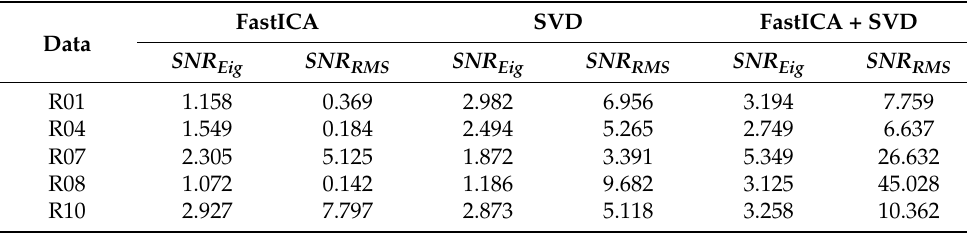
Table 1. Performance comparison of FECG signal extraction algorithms using the ADFECGDB database.